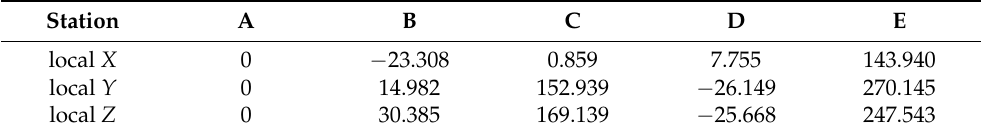
Table 2. Localized XYZ control coordinates.